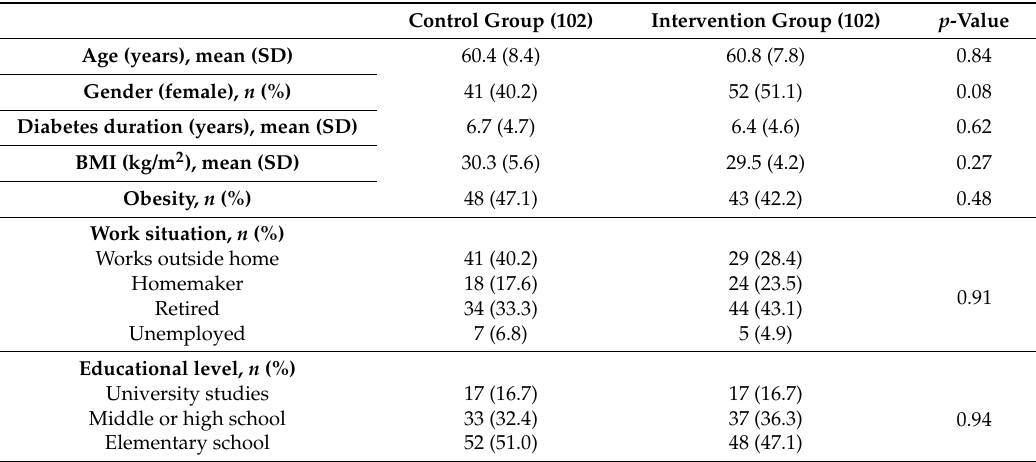
Table 1. Baseline characteristics of